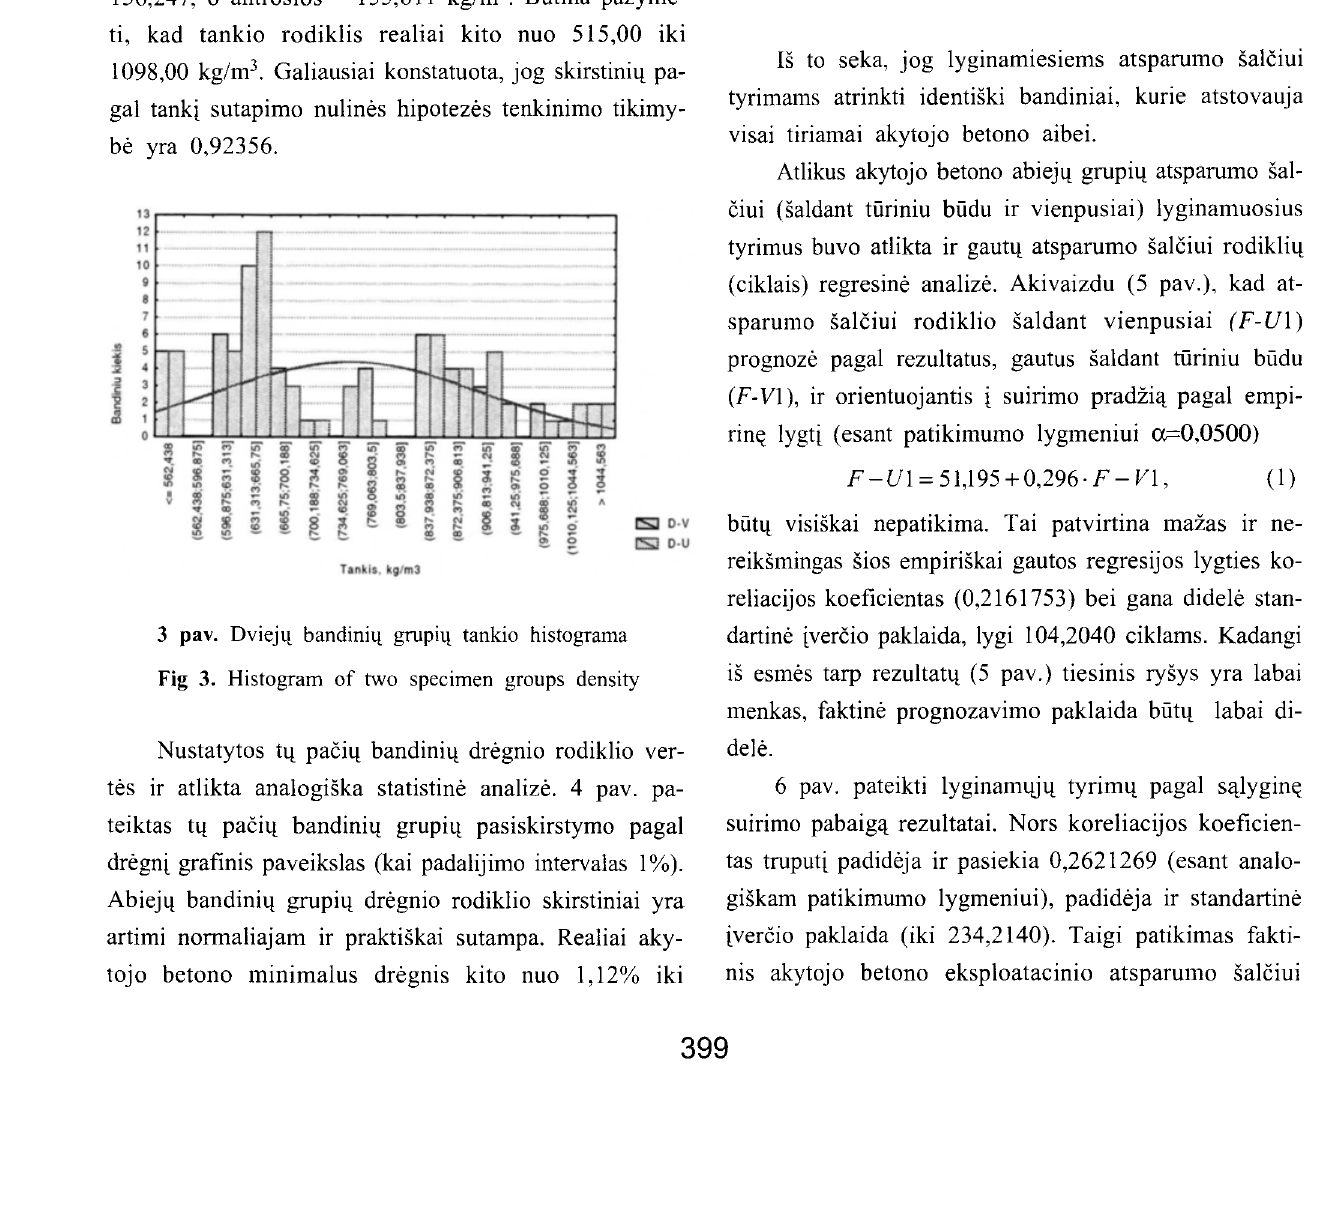
3 pav. pateiktas abiej4 atrinkttt bandiniq grupi4 pa siskirstymo pagal tanki grafinis vaizdas. Kaip matyti, abiejq grupi4 bandiniq skirstinys pagal tanki yra arti mas normaliajam. Si pasiskirstym~ apibudinanCios krei